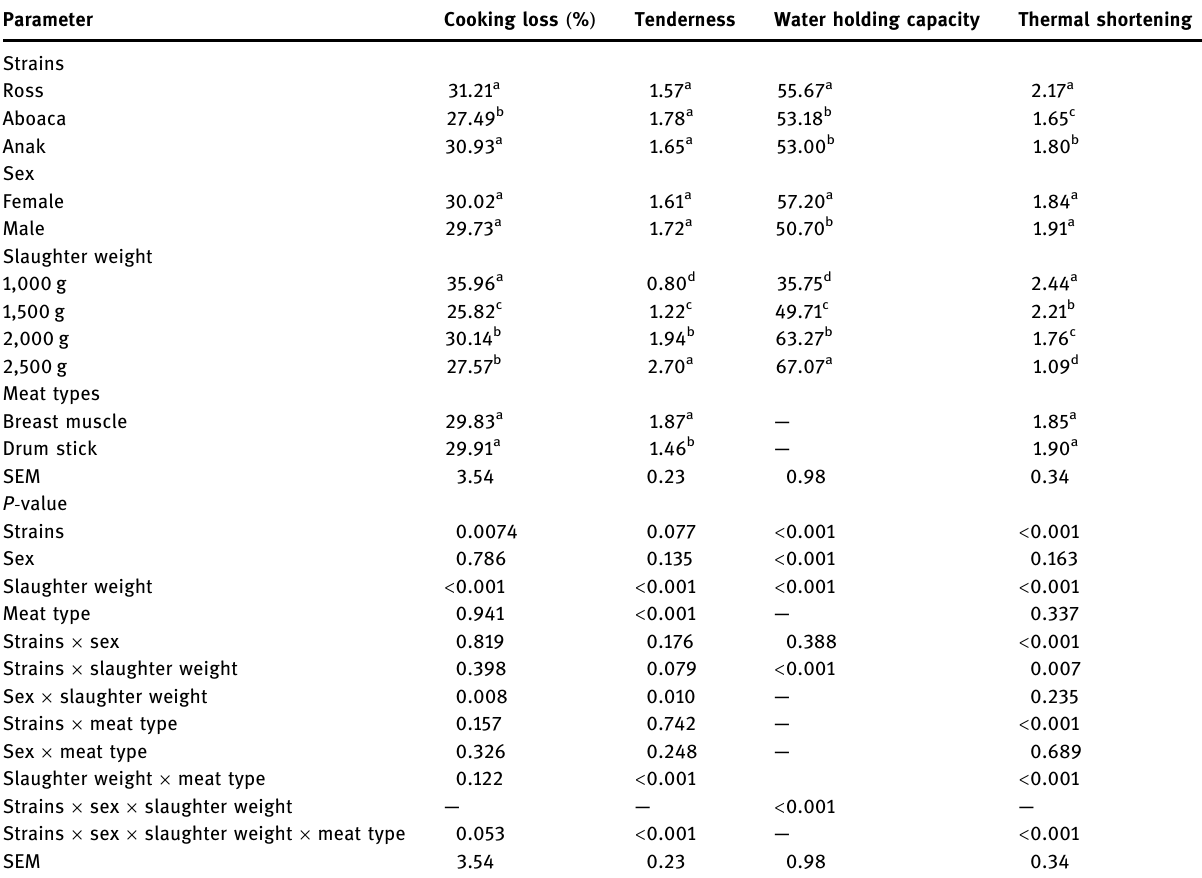
Table 5: Strain, sex and slaughter weight e ff ect on meat quality indicators of three commercial broiler chickens